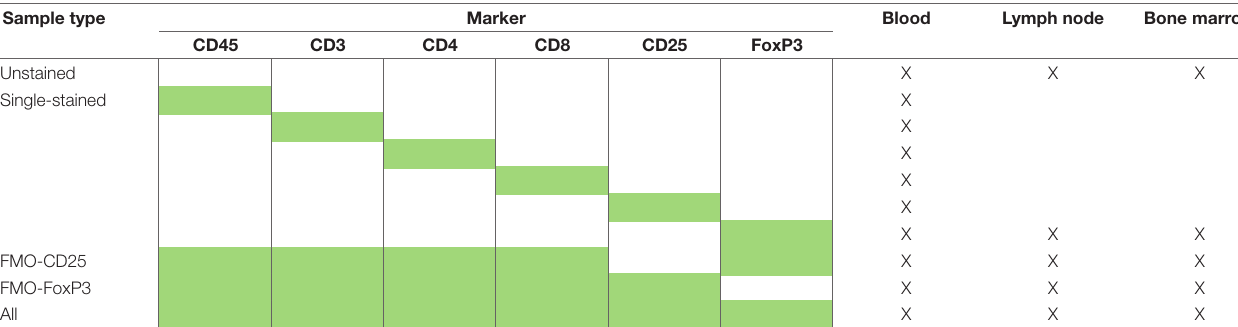
TABLE 2 | Fluorochrome compensation panel graph by sample type and